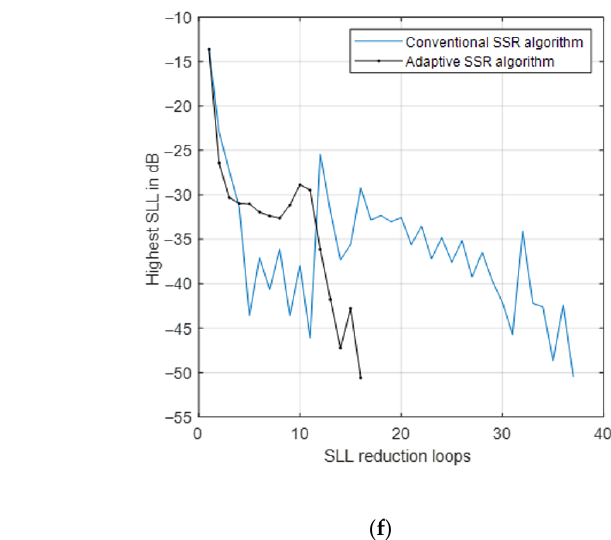
Figure 8. Convergence profile comparison between the conventional and optimized adaptive SSR learning curves at array size M of: ( a ) 16 elements, ( b ) 32 elements, ( c ) 64 elements, ( d ) 128 elements, ( e ) 256 elements, and ( f ) 512 elements.